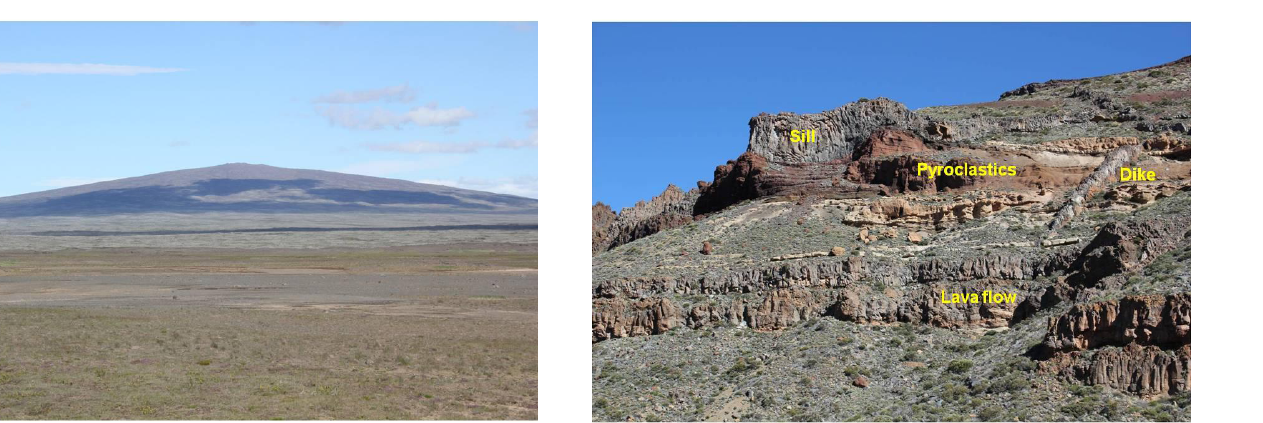
Fig. 3. Internal structure of a stratovolcano, here a part of the collapse caldera of Las Canadas volcano in Tenerife, Canary Islands. View looking east, the caldera wall is about 300m high. The rock units seen in the wall include felsic light-colored to brownish pyrolcastic layers, several basaltic sills and lava flows, as well as a prominent basaltic dike. Many of these layers and rock units have widely different mechanical properties.